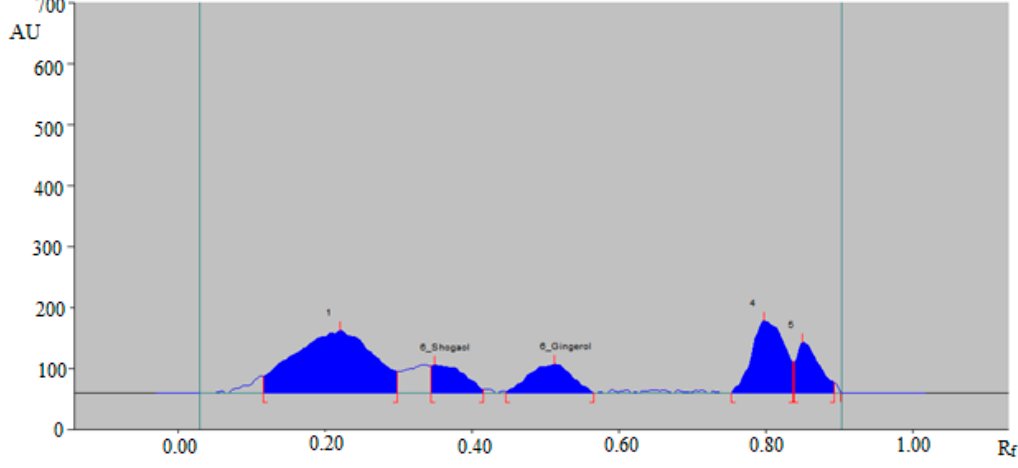
Figure 6. HPTLC-densitogram of 6-SHO and 6-GIN in traditional commercial capsules extract.